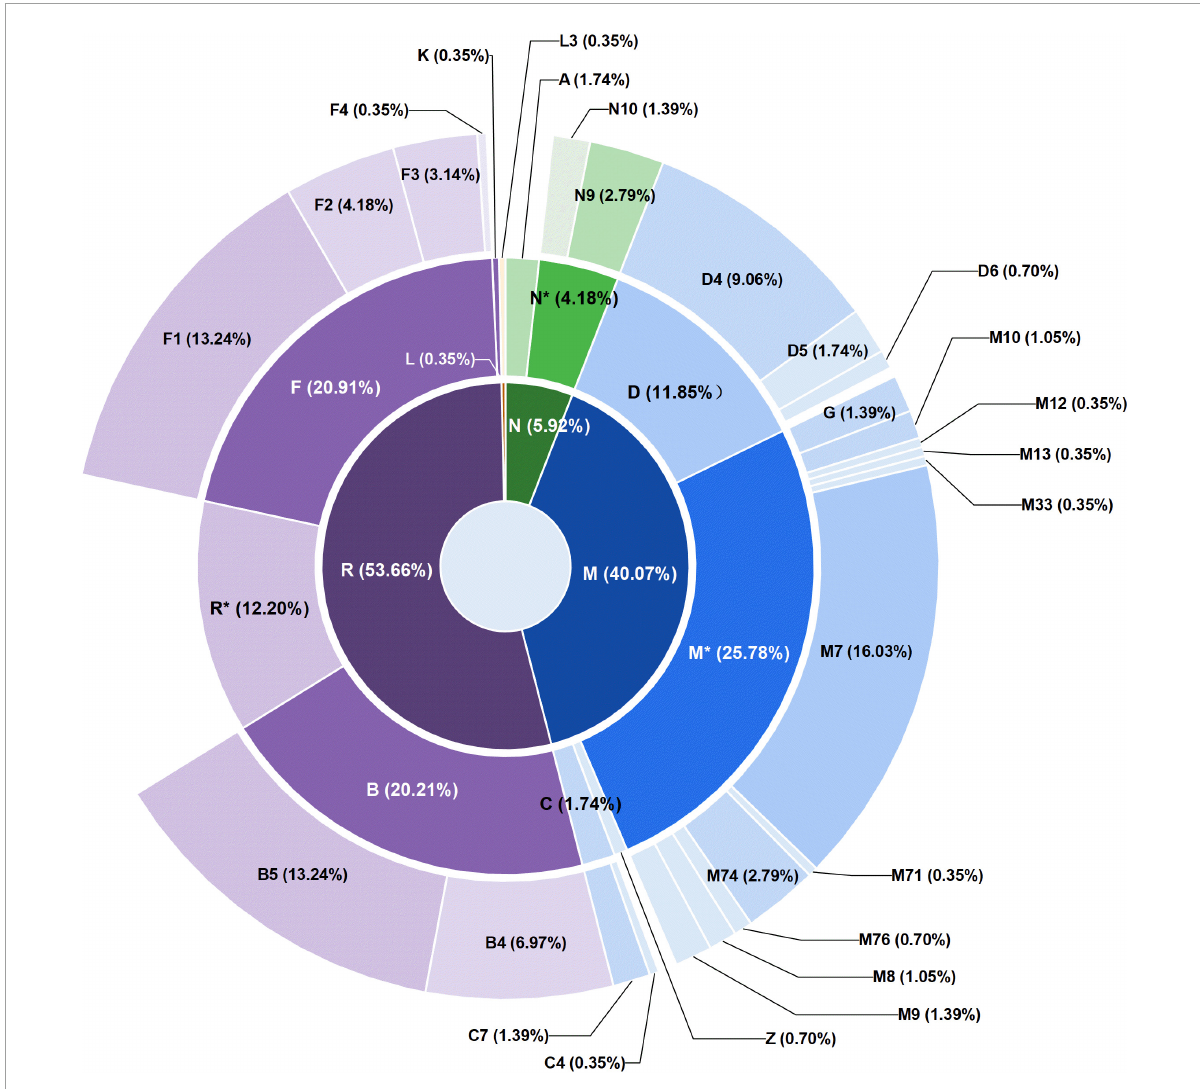
FIGURE4 Distribution of mitochondrial haplogroups in 287 individuals of Tai-Kadai in Guizhou. The macrohaplogroups M, N, and R displayed in the innermost circle are represented by different colors. The circle in the middle represents the distribution and proportion of each haplogroup belonging to macrohaplogroups M, N, and R. The outermost circle shows the distribution and proportion of sub-haplogroups in more detail.